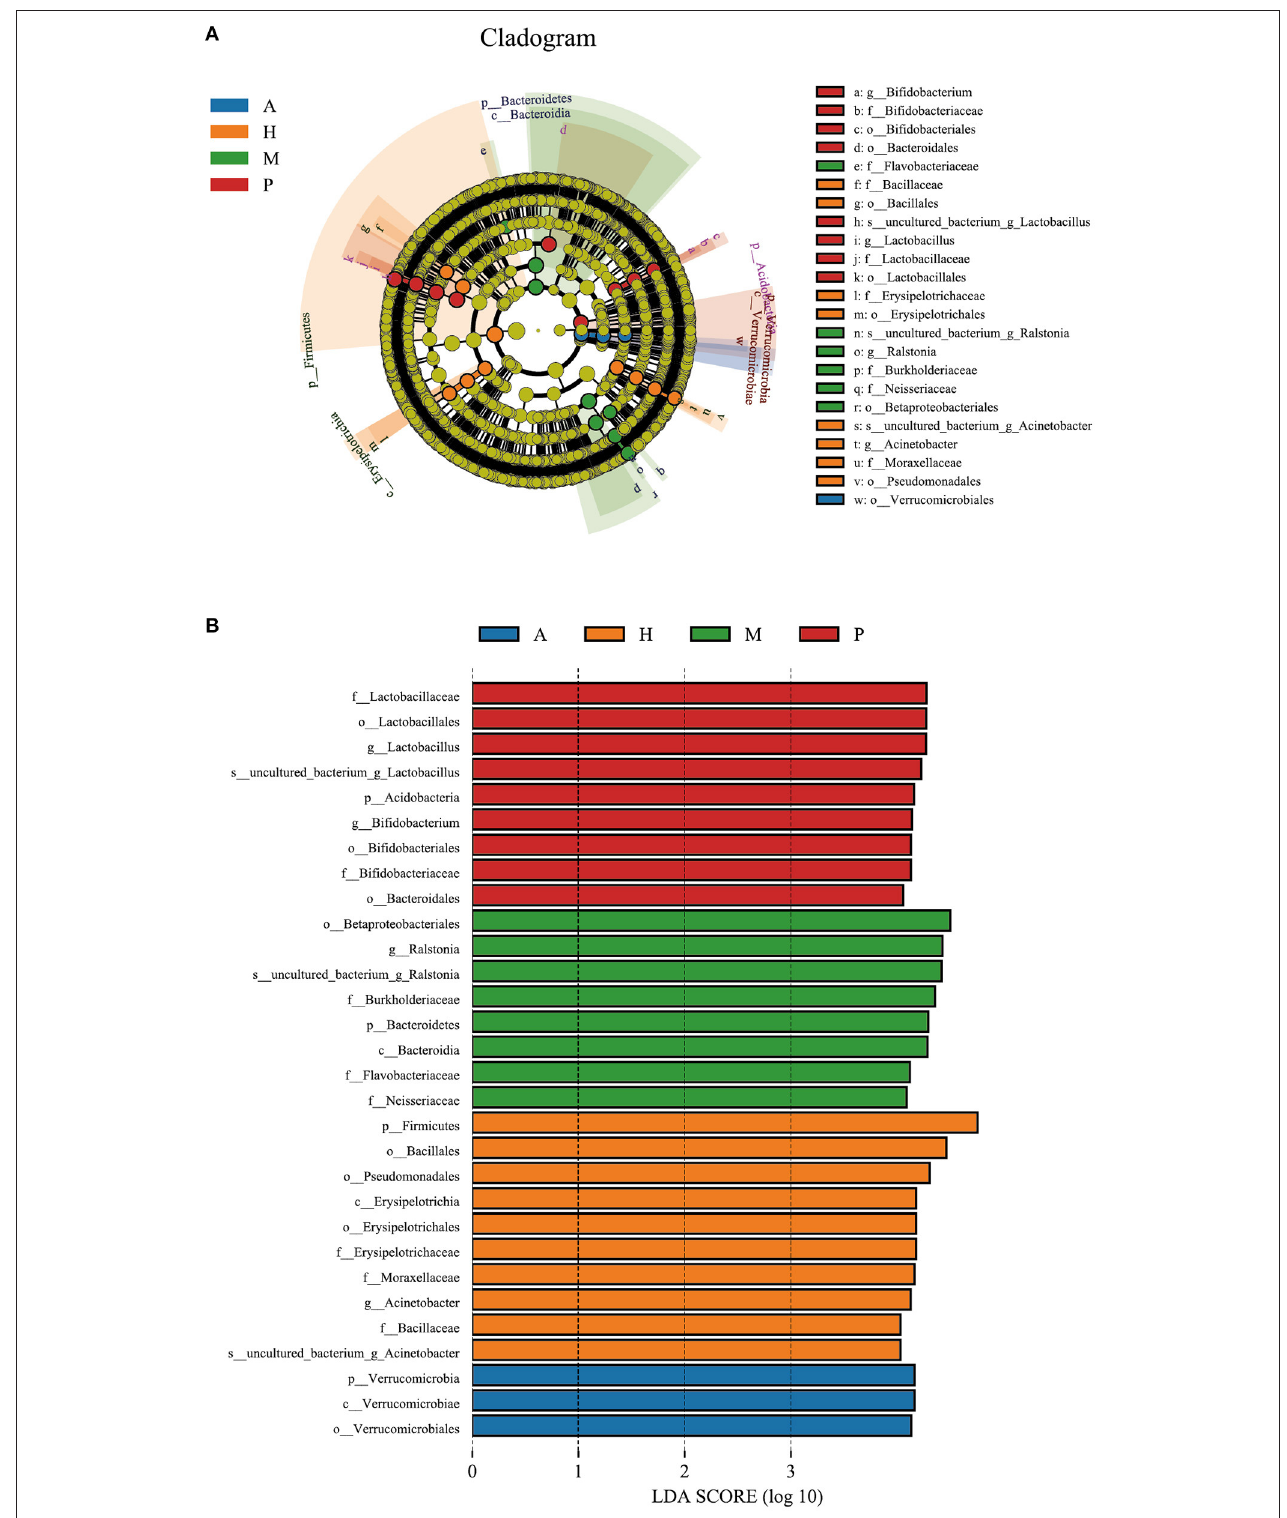
FIGURE 6 | LEfSe of the four groups. (A) A cladogram of the ocular surface microbial taxa in the anterior blepharitis group (A), posterior blepharitis group (P), mixed blepharitis group (M) and the healthy control group (H). The levels from phylum to species from outside to inside. (B) Linear discriminant analysis (LDA) scoring of biomarkers corresponding to (A), computed by the LEfSe tool. When the score of a taxon was > 4.0 with p < 0.01, it was listed in the histogram.